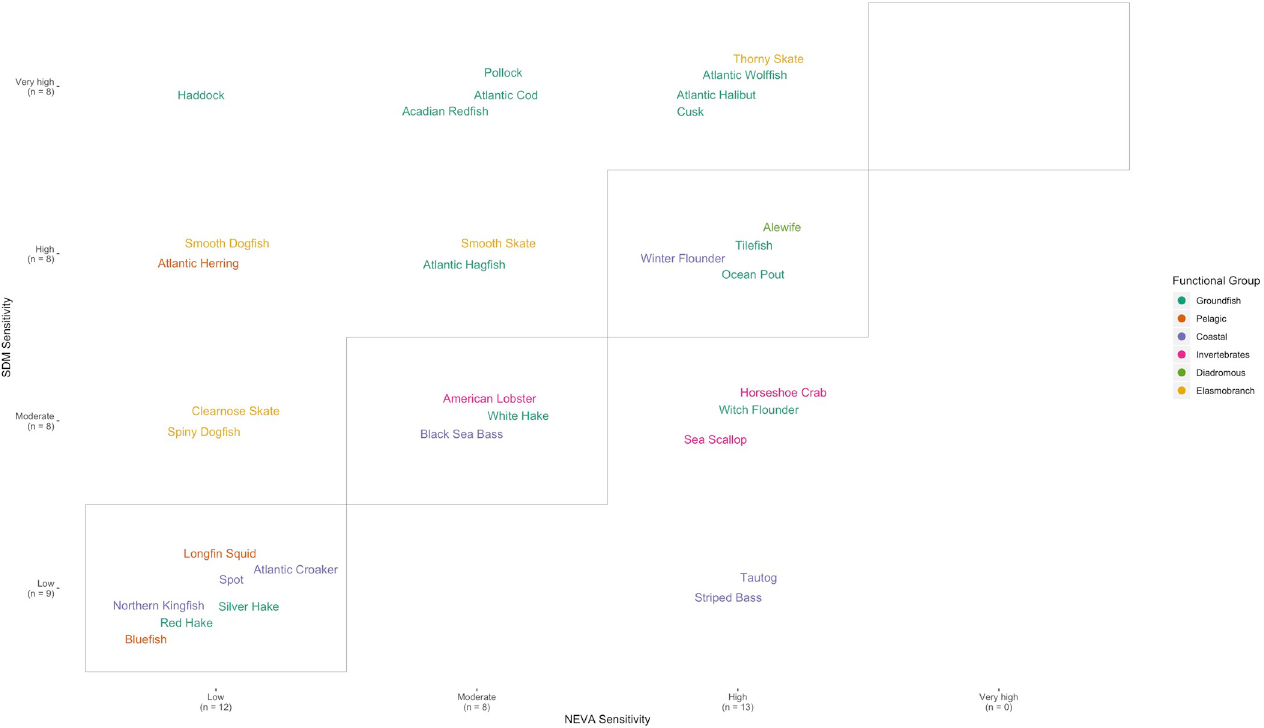
Fig 9. A comparison of sensitivity ranking as determined from the quantitative species distribution model (SDM Sensitivity) and from the qualitative expert vulnerability assessments (NEVA Sensitivity). Bordered diagonal tiles highlight species with matching sensitivity rankings between the two approaches. Along with the species names, the number of species in each sensitivity ranking are shown in